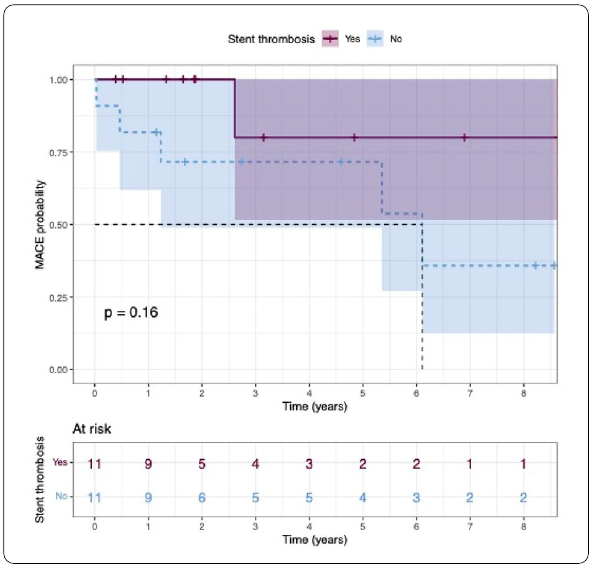
Figure 1. Diagnosis and therapeutic consequences according biopsy- based or noninvasive diagnosis work-up